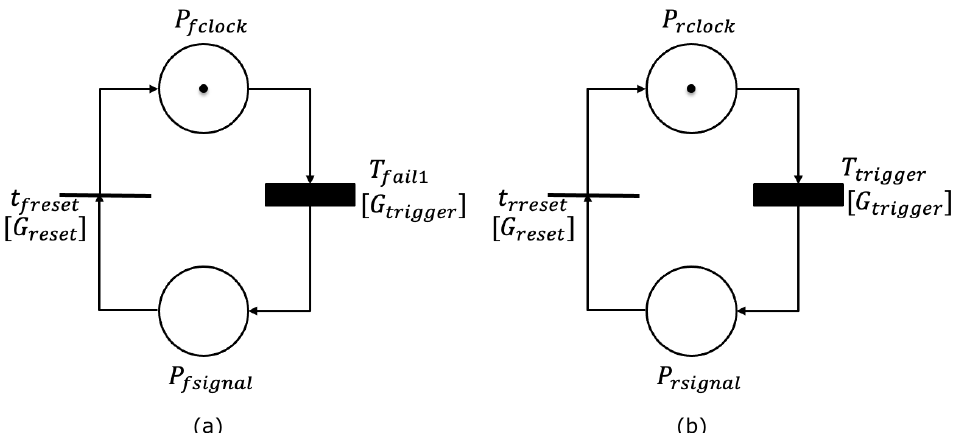
Figure 1. Clock models for ( a ) system aging and ( b ) software rejuvenation.